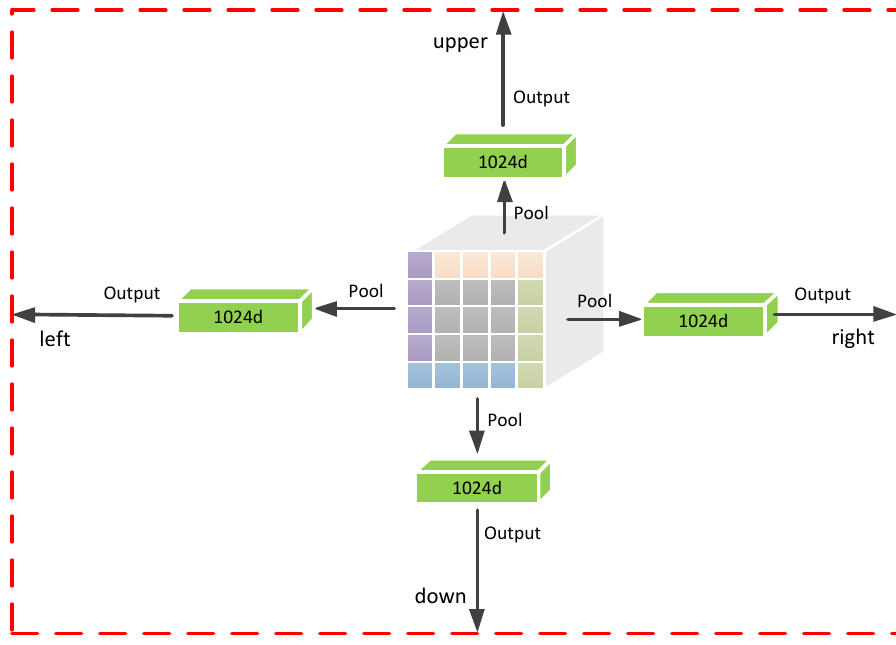
Figure 7. Illustration of the extreme point